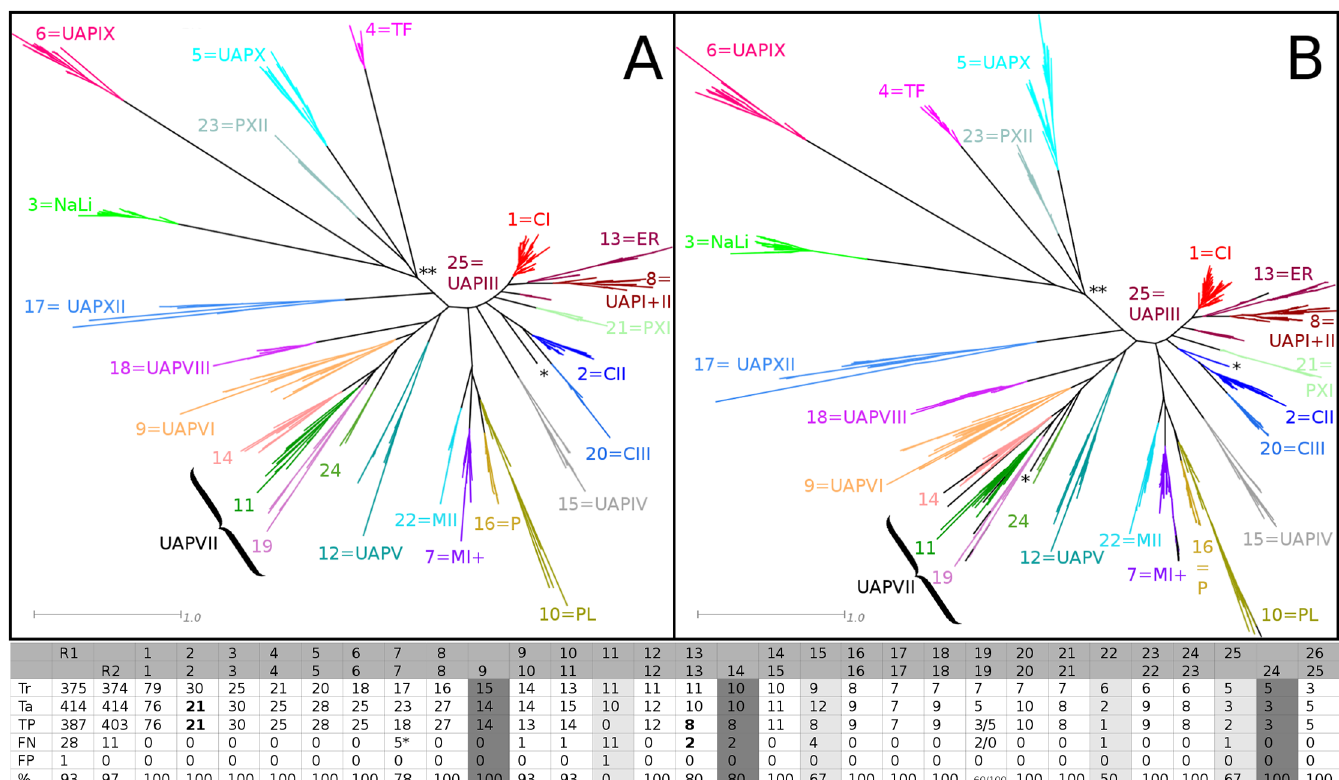
Fig 2. Optimized HMMERCTTER clustering and classification of plant ACD protein superfamily. (A) Training tree with clustering; clusters numbered according to HMMERCTTER and codes applied by Bondino et al., [22] (MI+ combines mitochondrial I (MI) and mitochondrial-like sHSPs (ML)). (B) Final and complete reference tree with classification made using clustering shown in A. Both A and B concern the second run as detailed in the text. Colors according to HMMERCTTER output, leaves in black could not be clustered or classified. Scale bars indicate 1 amino acid substitution per site. Note that UAPVII is represented by four clusters. UAPI and II were originally identified in the final 17 proteome dataset and correspond to a single clade in the training tree. (cid:3) indicates a single orphan training sequence that becomes classified in a paraphyletic clade. (cid:3)(cid:3) points to a local difference in tree topology that does not affect clustering and classification. The table shows the numerical results of HMMERCTTER classification. R1: 1 st run with specific columns in light-gray shade, R2: Optimized 2 nd run with specific columns in dark-gray shade. R1-G11 is R2-G14; R1-G25 is R2-G24; and R2-G9 consists of R1-G15 and R1-G22. For details see context and S2 Fig. Tr = Train; Ta = Target; TP = True Positives; FP = False Positives; FN = False Negatives; % = classification recall (TP/(TP + FN)). Boldface numbers include paraphyletic sequences. (cid:3) Concerns distant sequences as shown in S3 Fig. Note that both the total number of train and target sequences include one orphan sequence each and that the single false positive is a training sequence.